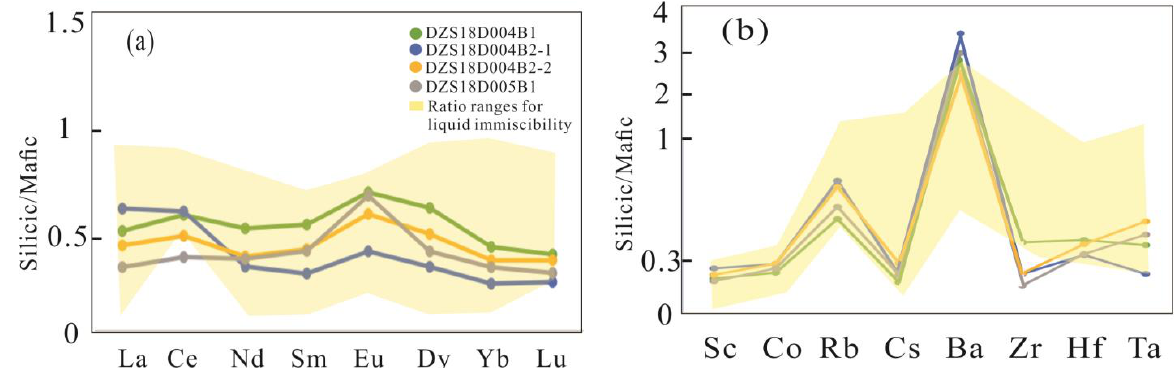
Figure 11. Ratios of REE elements ( a ) and trace elements ( b ) in dark enclaves to their corresponding host granitoids. Ranges for ratios of REE elements ( a ) and trace elements ( b ) in silicic liquid to those in mafic liquid are based on data from [80,89,93,94].